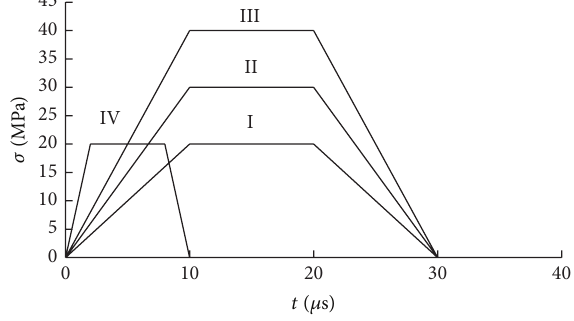
Figure 3: Different stress waves exerted on